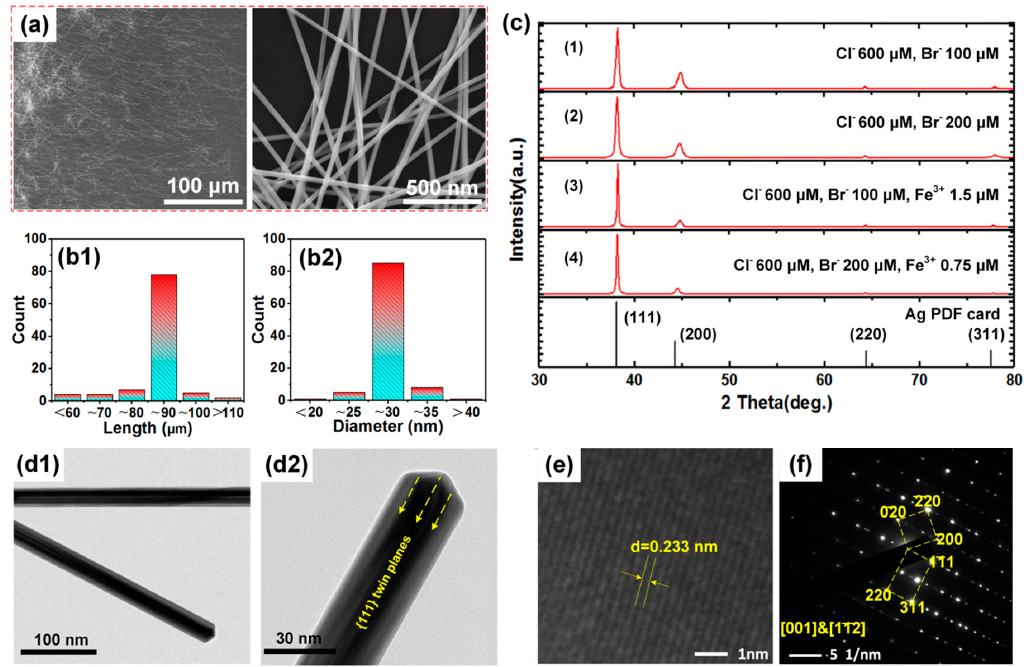
Figure 6. ( a ) SEM images of products synthesized with 600 µM of NaCl, 200 µM of NaBr and 0.75 µM of Fe(NO 3 ) 3 . The histograms of length and diameter distribution of the AgNWs are, respectively, shown in ( b1 , b2 ). ( c ) X-ray diffraction (XRD) patterns of AgNWs prepared with different mediated agents. ( d1 , d2 ) Transmission electron microscope (TEM) images and ( e ) high-resolution TEM (HRTEM) image of the as-prepared AgNWs. ( f ) Selected area electron diffraction (SAED) pattern taken from an individual Ag nanowire.